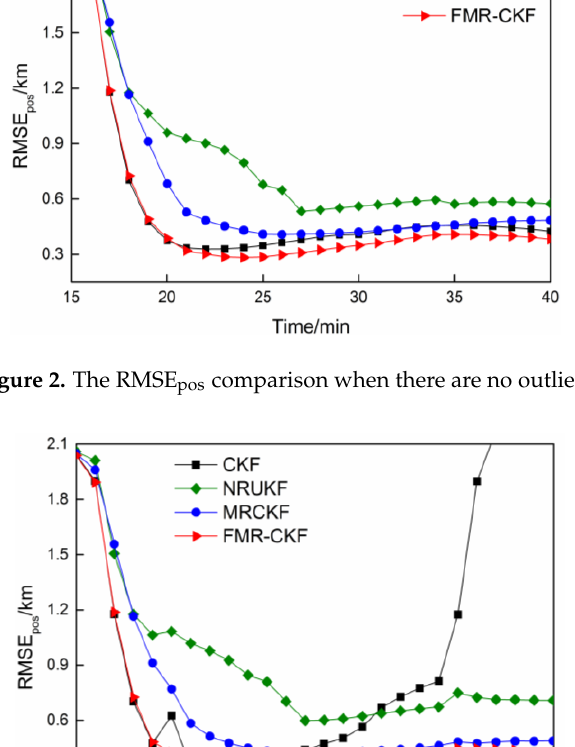
Figure 2. The RMSE pos comparison when there are no outliers.